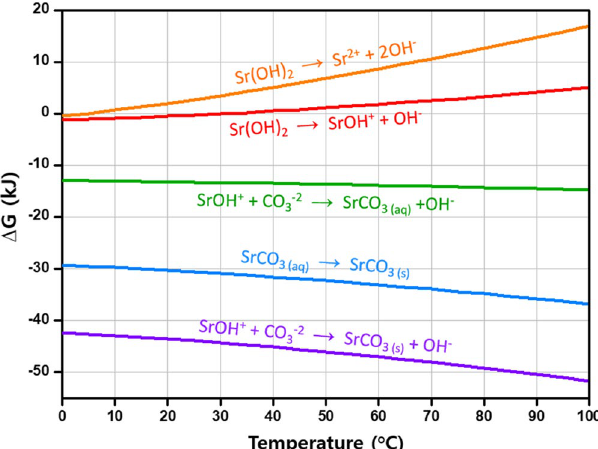
Figure 6. Gibbs free energy changes for the plausible reactions of strontium hydroxide and carbon ions in aqueous solution at 0–100 °C, plotted using HSC Chemistry